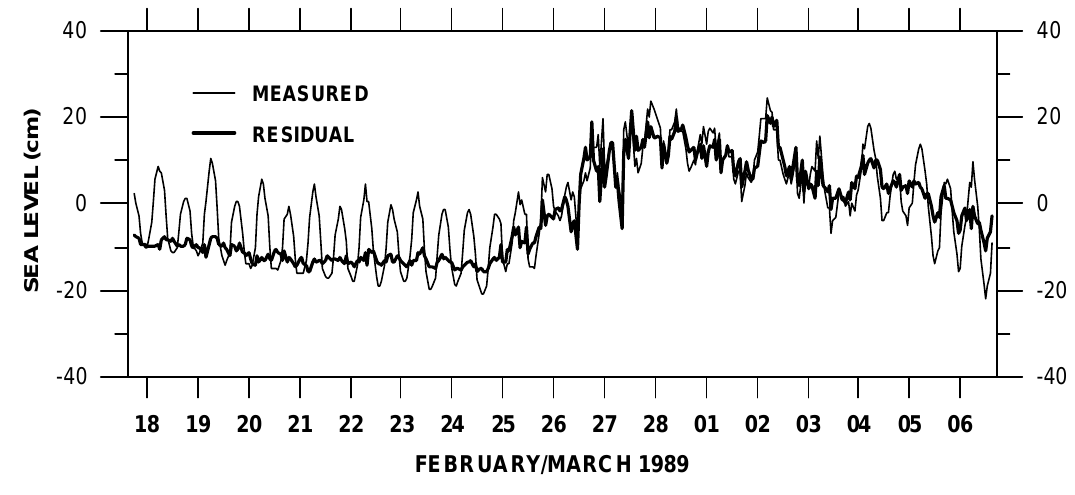
Fig. 11. Time series of measured and residual sea levels at